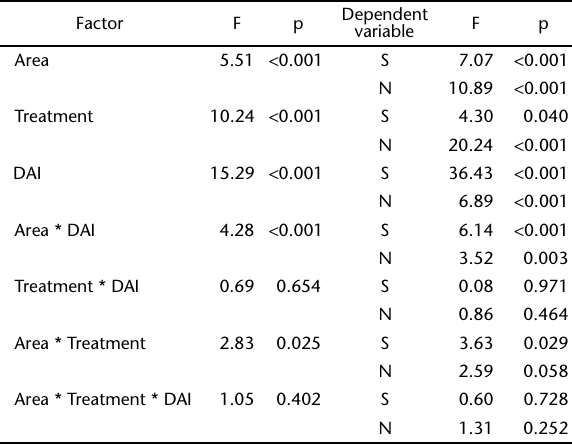
Table II. Multivariate GLM results and tests for between-subject effects for spider variables (abundance and species richness) considering three factors: treatment (with and without insecticide), areas (three sites in Rio Grande do Sul, Brazil) and time in days after insecticide application (DAI), and their interactions. Years are included as blocks (not shown). See text for details.